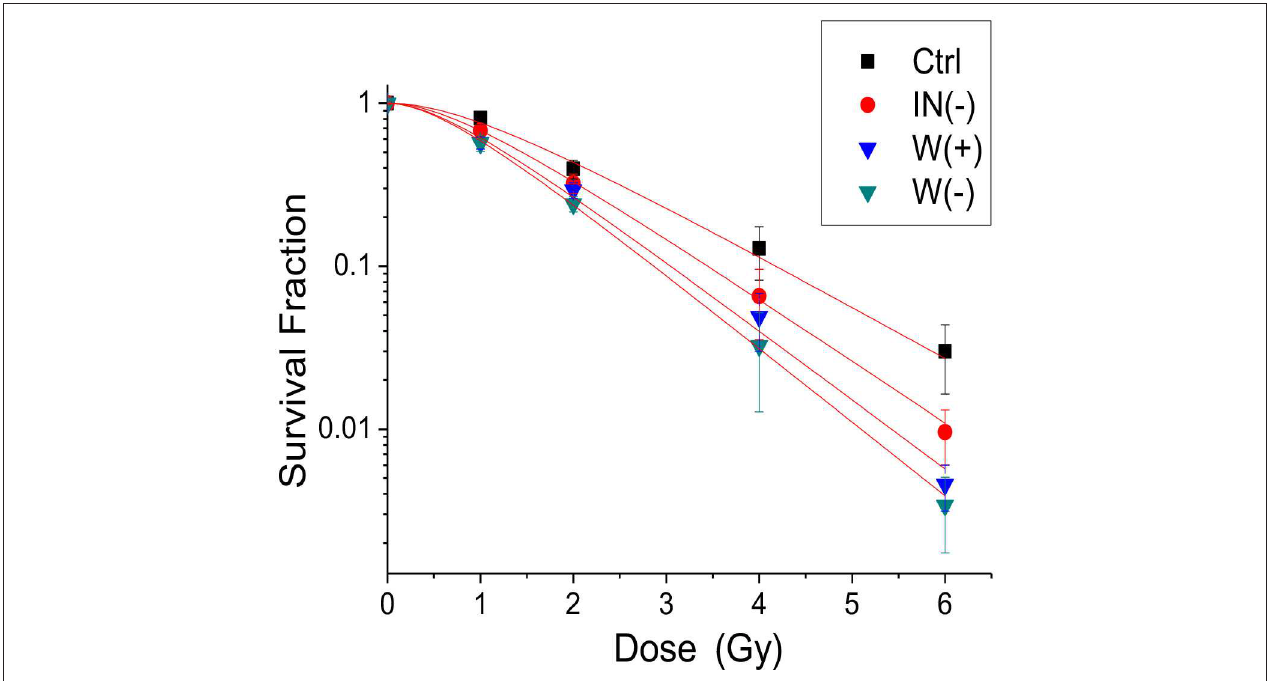
FIGURE 1 | Radiation dose enhancement studies. Clonogenic assays of HepG2 tumor cells post-AGuIX incubation (1h). Ctrl is the control group with no AGuIX incubation. IN (–) is AGuIX not incubated, W ( + ) represents AGuIX incubation and washed, W (–) is AGuIX incubation without washing. Linear quadratic models were fitted to experimental